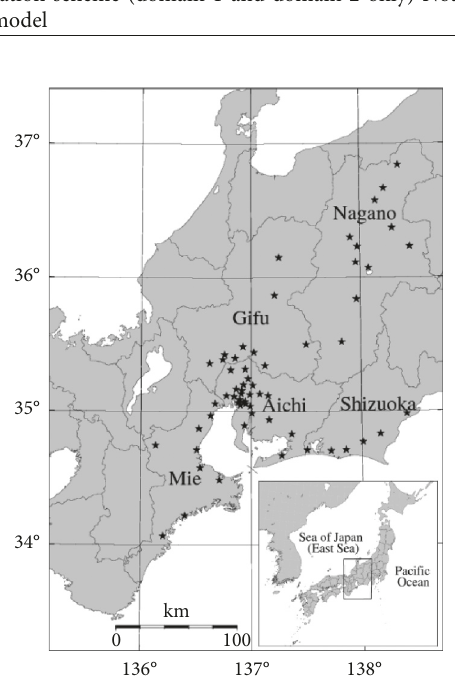
Figure 1: Study region and distribution of the radiometric stations with global irradiance measurements (dark